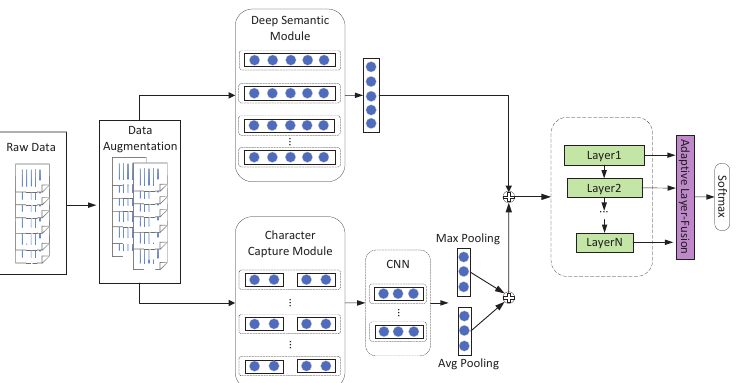
Figure 1. The overall framework of our proposed based on data augmentation multi-semantic fusion neural network model